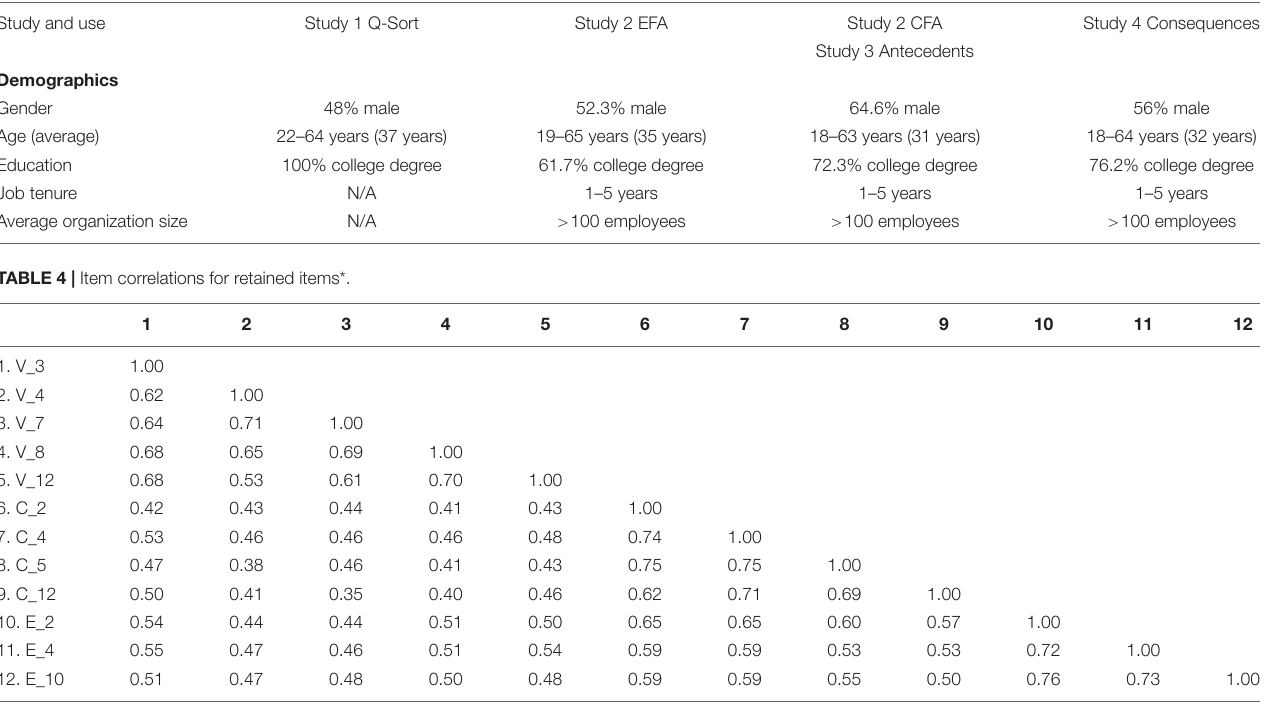
TABLE 3 | Summary of samples.